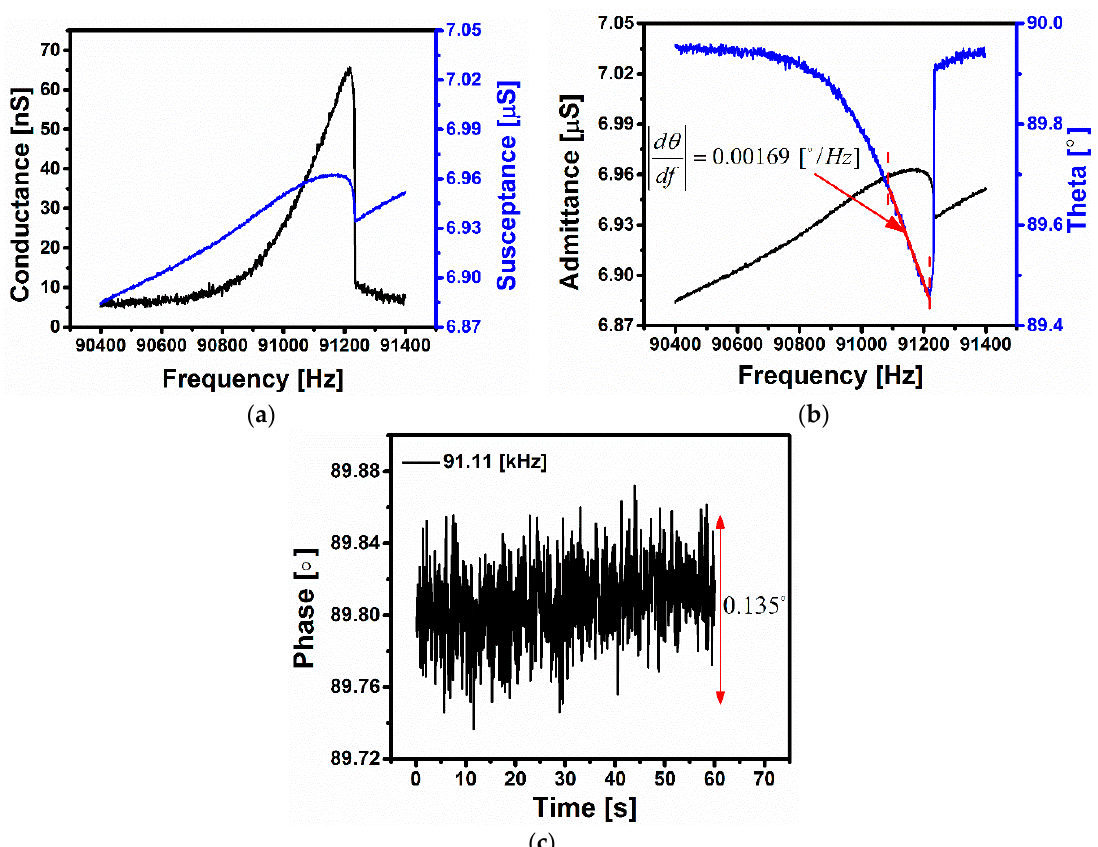
Figure A1. Noise analysis at a voltage load of V DC = 3 V and V AC = 1 V and at a pressure of 220 mTorr. ( a ) Conductance and susceptance as a function of the frequency near resonance; ( b ) Admittance and phase as a function of the frequency near resonance; ( c ) Variation of the phase in time at f = 91.11 kHz. The phase evolution as a function of time at a fixed frequency has been shown in Figure A1c.